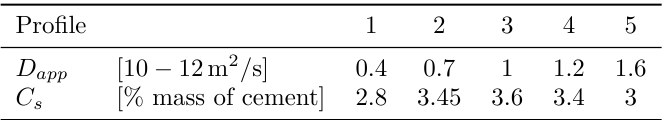
Table 3. Di ff usion Coe ffi cient, D app , and surface chloride concentration, C s , of imaginary chloride profiles.